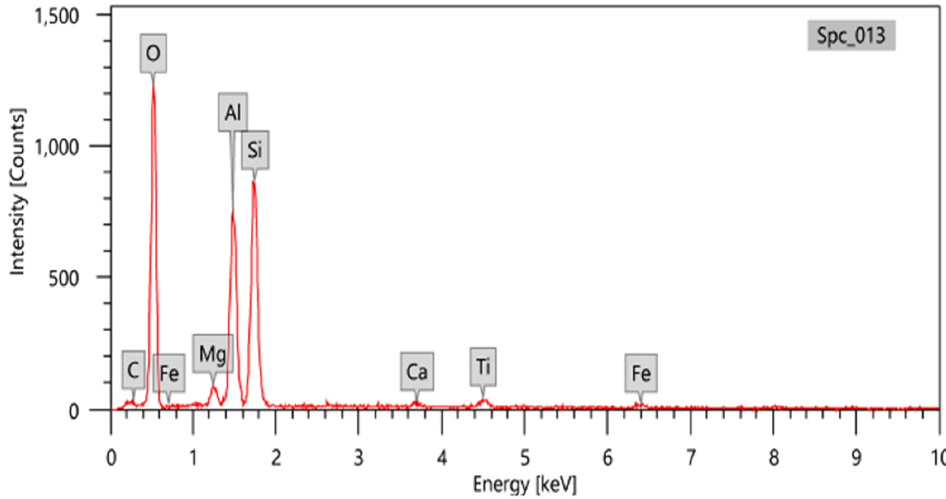
Table 2. The percentages of compositional oxides in kaolin clay.